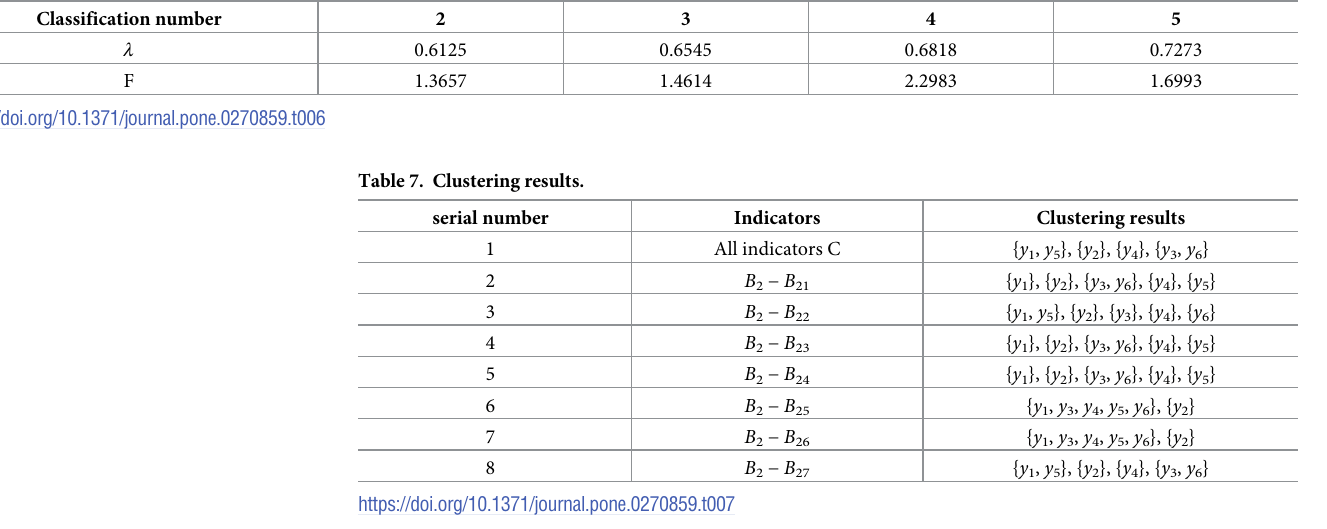
The process of rough intensive reduction is to remove one indicator each time to conduct grey clustering, find the best clustering result, compare it with the original clustering result, and delete the indicator that has no influence on the clustering result. In this study, the whole sample set consists of 6 senior experts. Each indicator of digital economy represents condi- tional attribute set C , and the sample clustering result represents decision attribute set D . In this paper, B ~ B were successively deleted for gray dynamic clustering. The clustering 21 27 results are shown in Table 7.